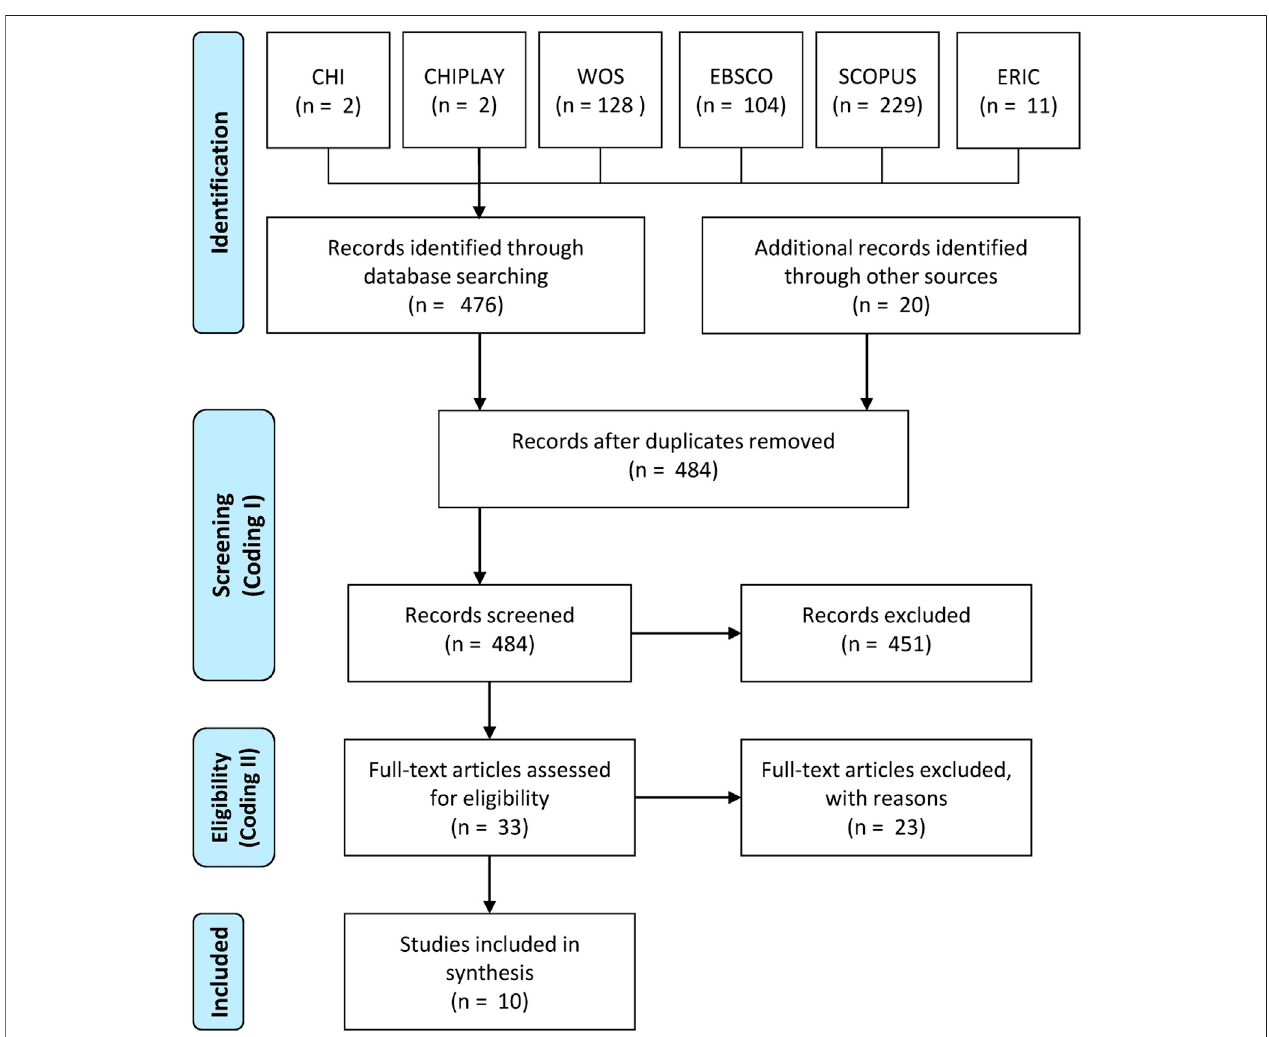
FIGURE 1 | Study collection fl owchart; based on Moher et al.